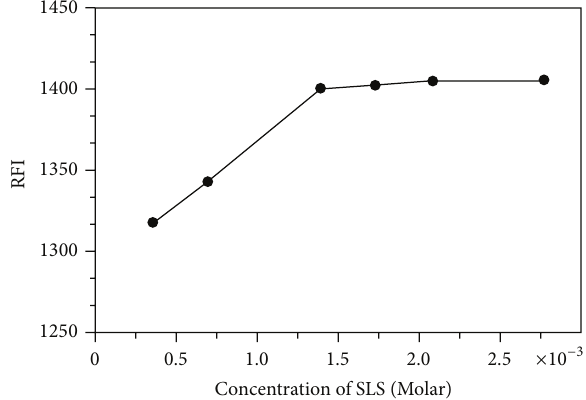
Figure 4: Effect of sodium lauryl sulfate (SLS) concentration (Molar) on fluorescence intensity of MRZ (100